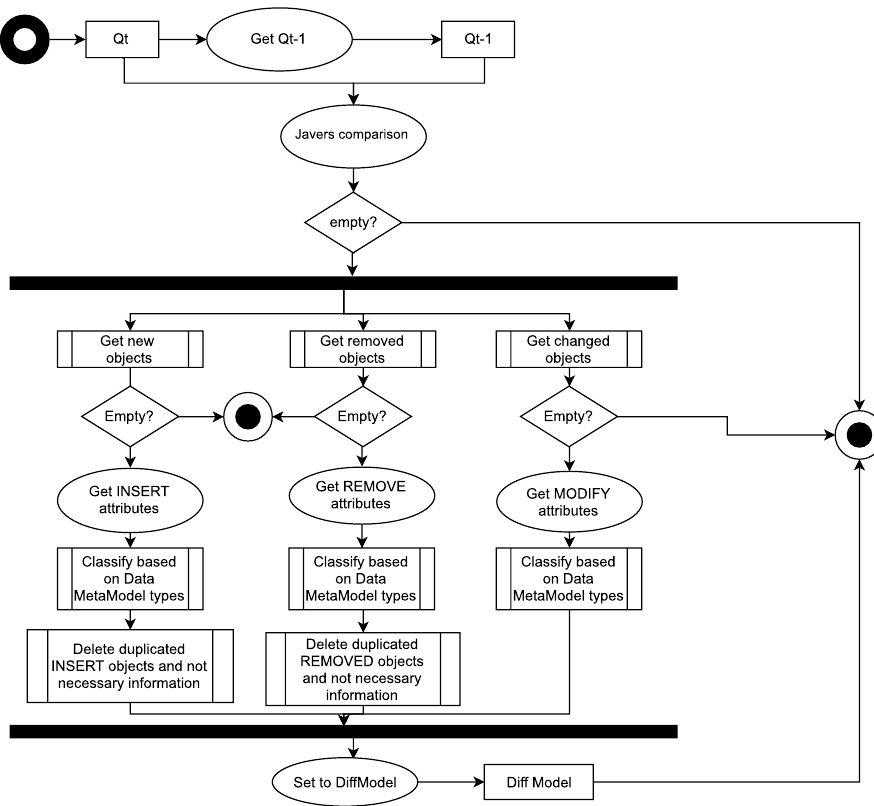
Figure 4. The Diff Model creation a